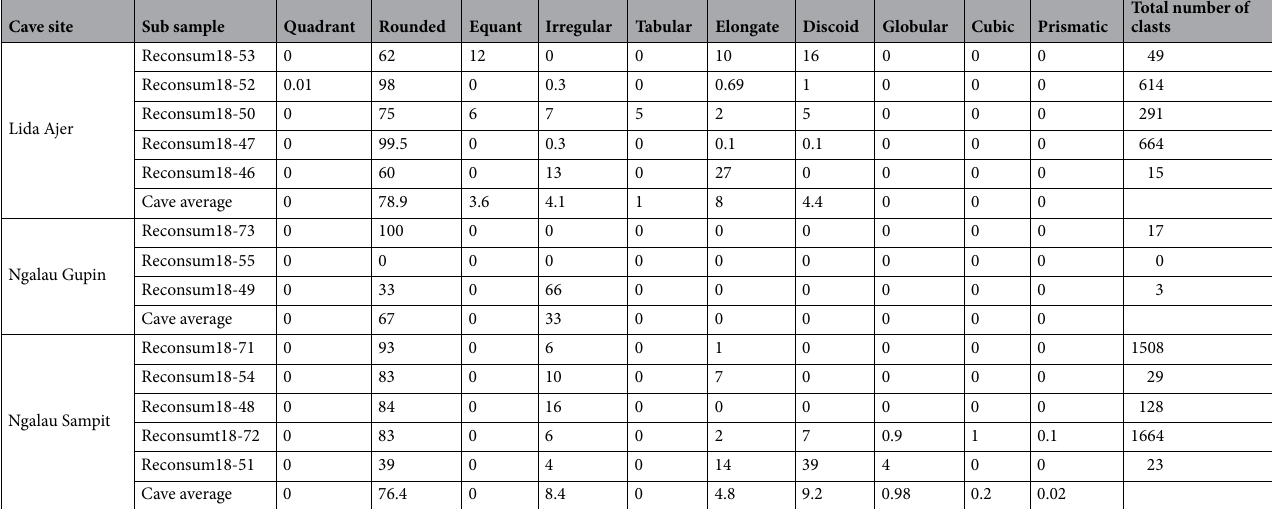
Table 2. The percentage of clasts in each discrete breccia sample of a particular shape, and the average result for each individual cave, with the average result calculated below. The shape classifications are adapted from Stoops 45 and Mackenzie et al. 46 . The average results in each individual cave is calculated below each set of subsamples.